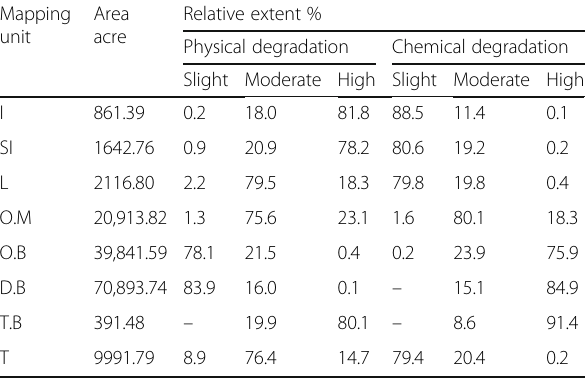
Table 8 Relative extent (%) of the natural vulnerability classes in the study area Mapping Area unit